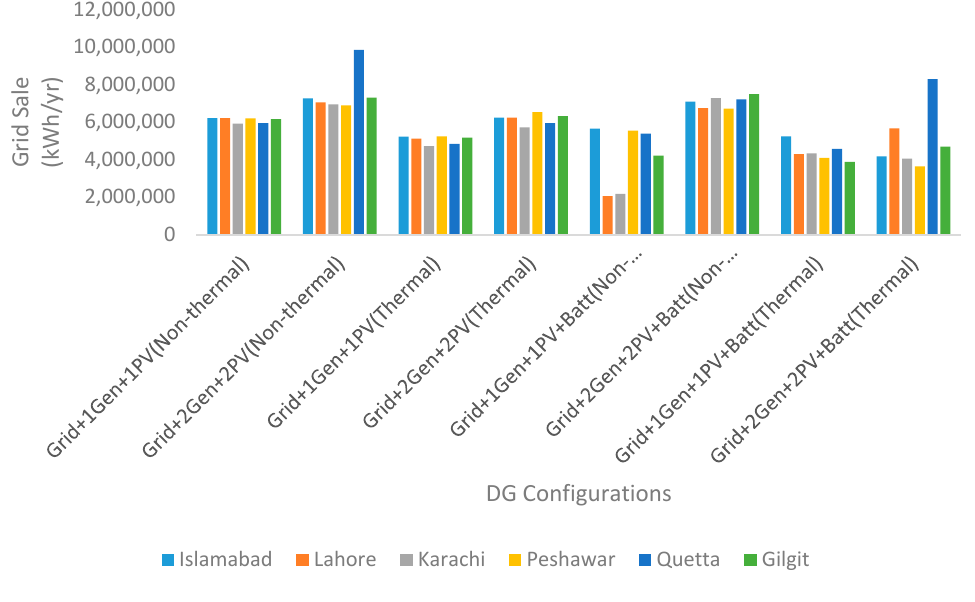
Figure 14. Grid sales comparison